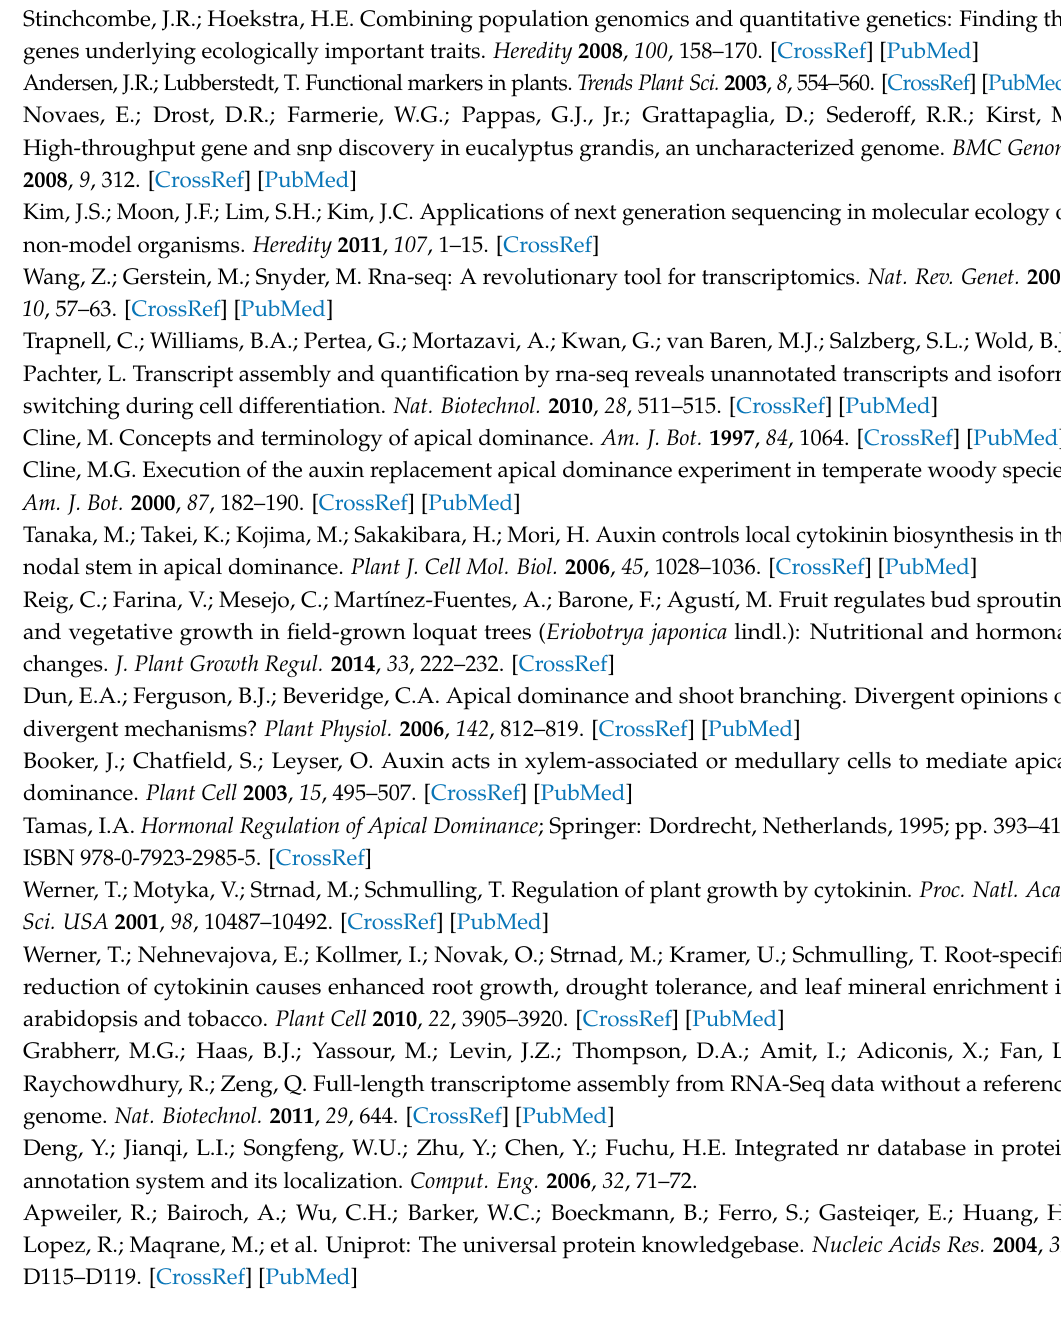
Figure S2: The pathway map of ko04075. The dataset is available from the NCBI Short Read Archive (SRA) with an accession number SRX2024410